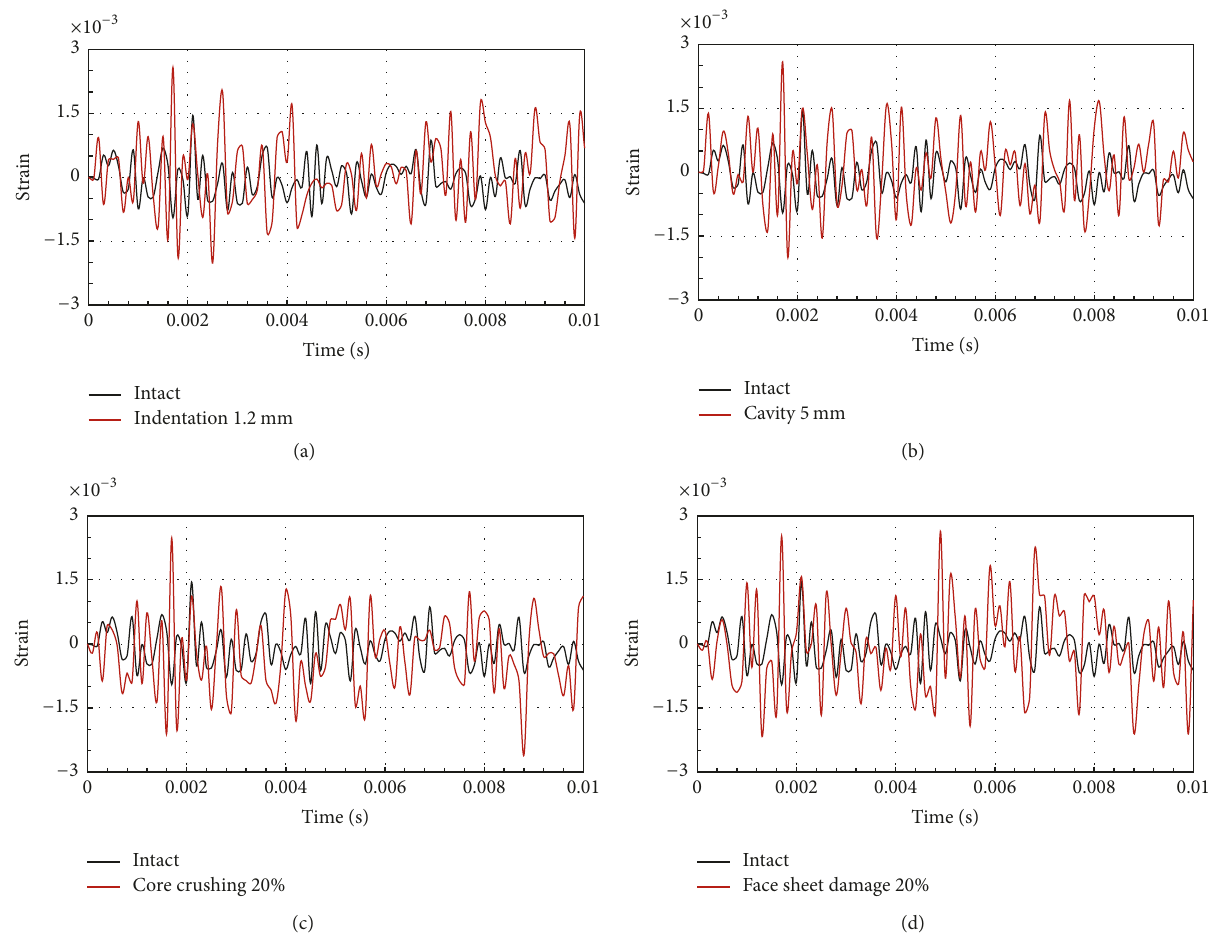
Figure 19: The transient behaviour of the impacted sandwich plate depending on [72] (a) indentation of face sheet; (b) cavity between face sheet and core; (c) level of core crushing; and (d) level of face sheet damage.